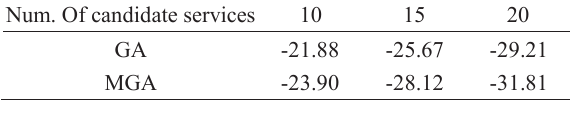
Num. Of candidate services